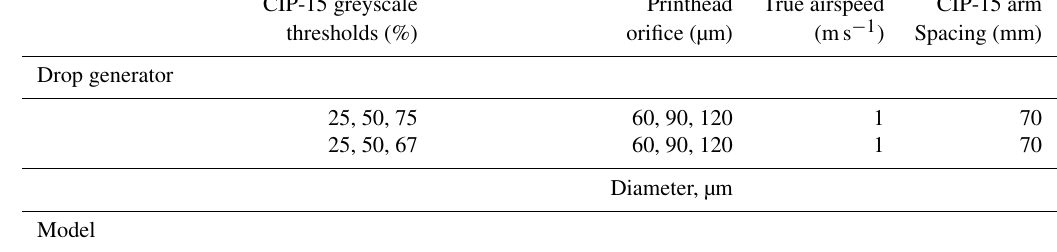
Table 1. A summary of the main instrumental and experimental characteristics of the laboratory, model and airborne measurements. CIP-15